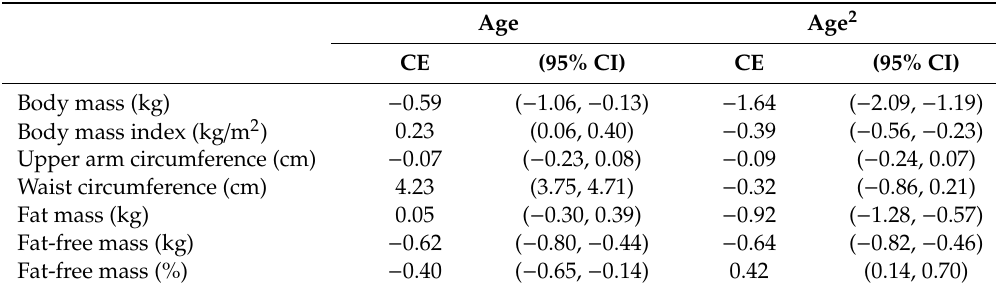
Table 2. Age-related changes in parameters of anthropometry and body composition before considering potential influencing factors ( n =